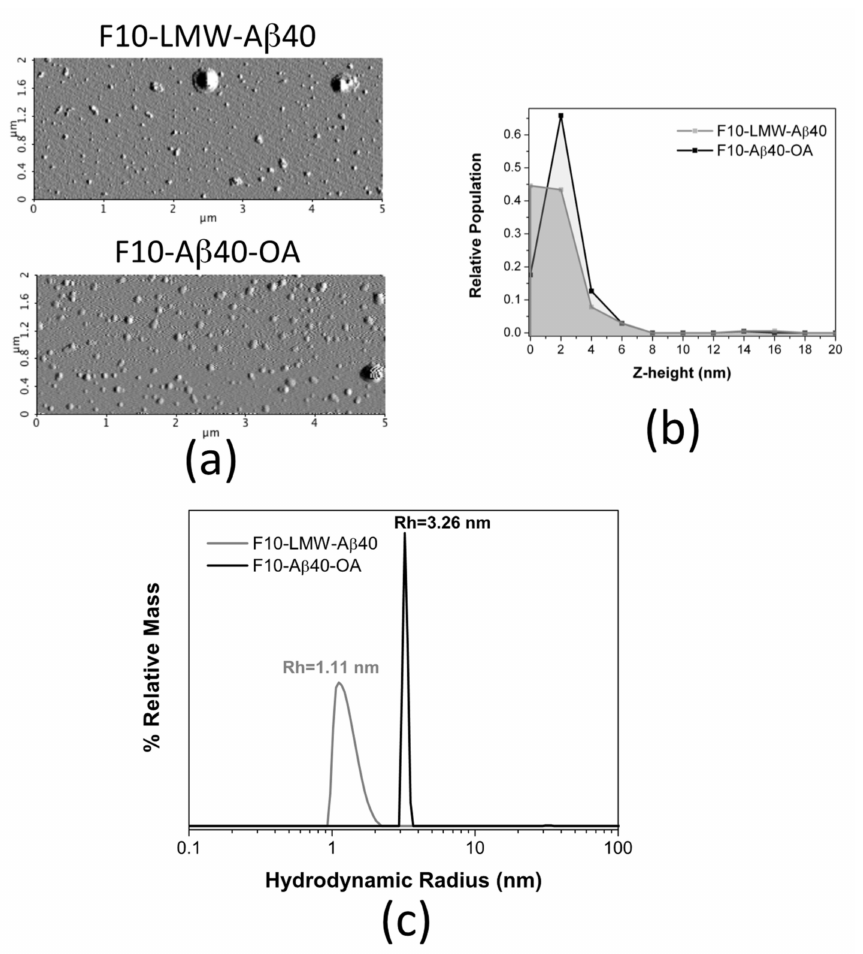
Figure 9. Biophysical properties comparison between F10-A β 40-OA and F10-LMW-A β 40. ( a ) Repre- sentative AFM amplitude images of freshly prepared F10-LMW-A β 40 and F10-A β 40-OA. Relative frequencies of the Z-height (nm) for F10-LMW-A β 40 (grey) and F10-A β 40-OA (black) ( b ). ( c ) Particle size distributions obtained by DLS for F10-LMW-A β 40 (c = 25 µ M) (grey line) and F10-A β 40-OA (c = 25 µ M) (black